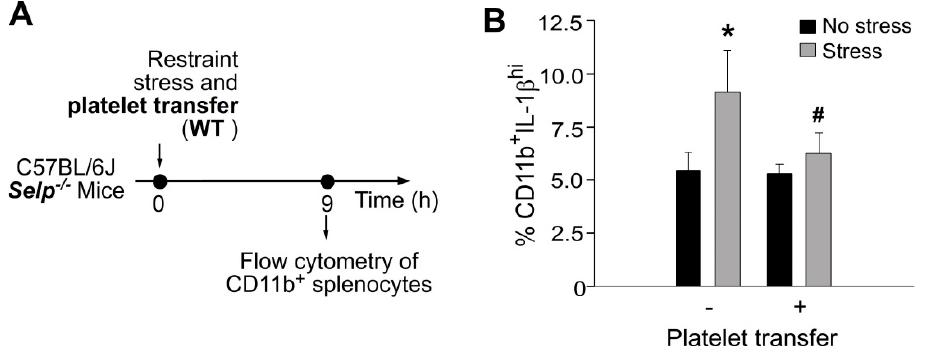
Figure 5. Stress-induced up-regulation of splenic CD11b + IL-1 β hi proinflammatory monocytes was ameliorated by platelet transfer in mice. ( A ) Experiment outline of restraint stress mouse model. ( B ) Flow cytometry analysis of CD11b + IL-1 β hi monocytes from Selp − / − mice with or without stress, and with or without wild-type (WT) platelet transfer. CD11b: monocyte marker; IL-1 β : pro-inflammatory cytokine. * p < 0.05 vs. no stress groups; # p < 0.05 vs. without platelet transfer groups. n = 6 (three experiments with total six mice per group).